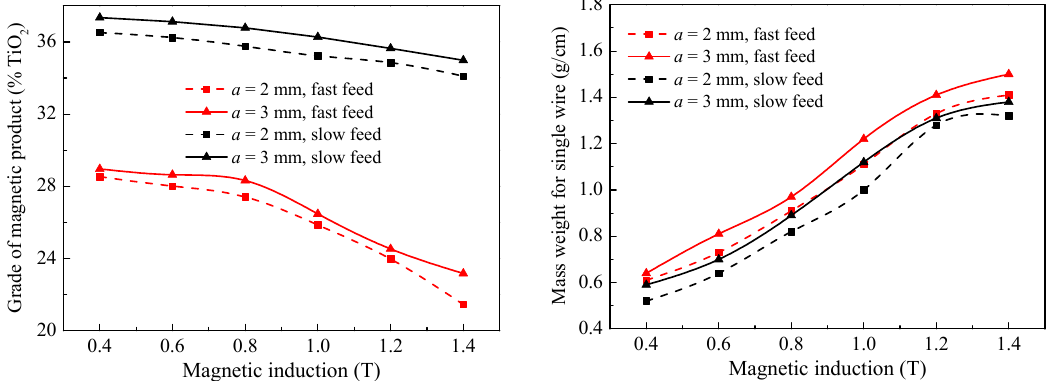
Figure 7. Effect of magnetic induction on capture selectivity ( left ) and capture capacity ( right ) of single wire with different feed modes.